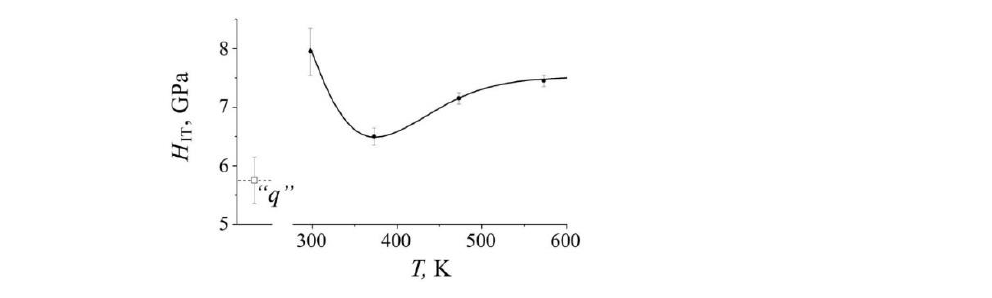
Figure 11. The dependence of the hardness H IT on the deformation temperature of HPT ( n = 3 rev.) of the quenched FeMn 22 Cr 18 N 0.83 steel; the point “ q ” corresponds to the hardness of the initial quenched sample.